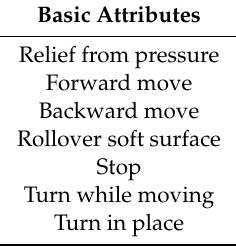
Table 1. Basic skills, the designed wheel chair is capable of.